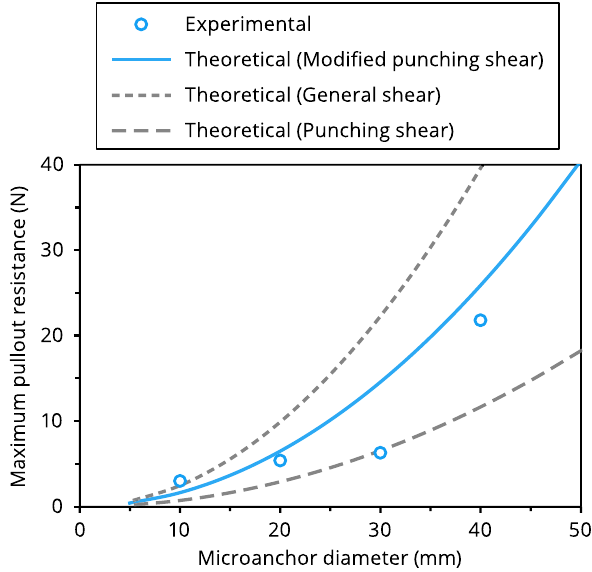
Figure 3. Comparison between experimental and theoretical maximum pullout resistances at varying diameters of disc-shaped microanchor. In addition to modified punching shear failure adopted in this study for describing microanchor bearing failure, upper- and lower-bound values constrained from general and punching shear failure mechanisms are also depicted. The input parameters for theoretical modeling are: σ n = 1.36